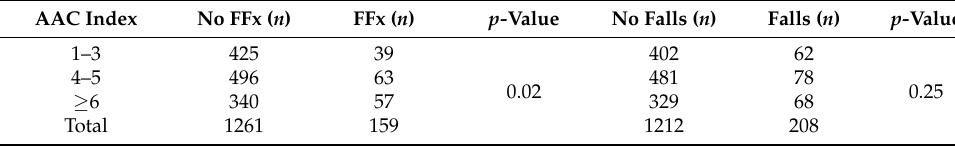
Table 3. Frequencies of participants with or without FFx and falls in different AAC